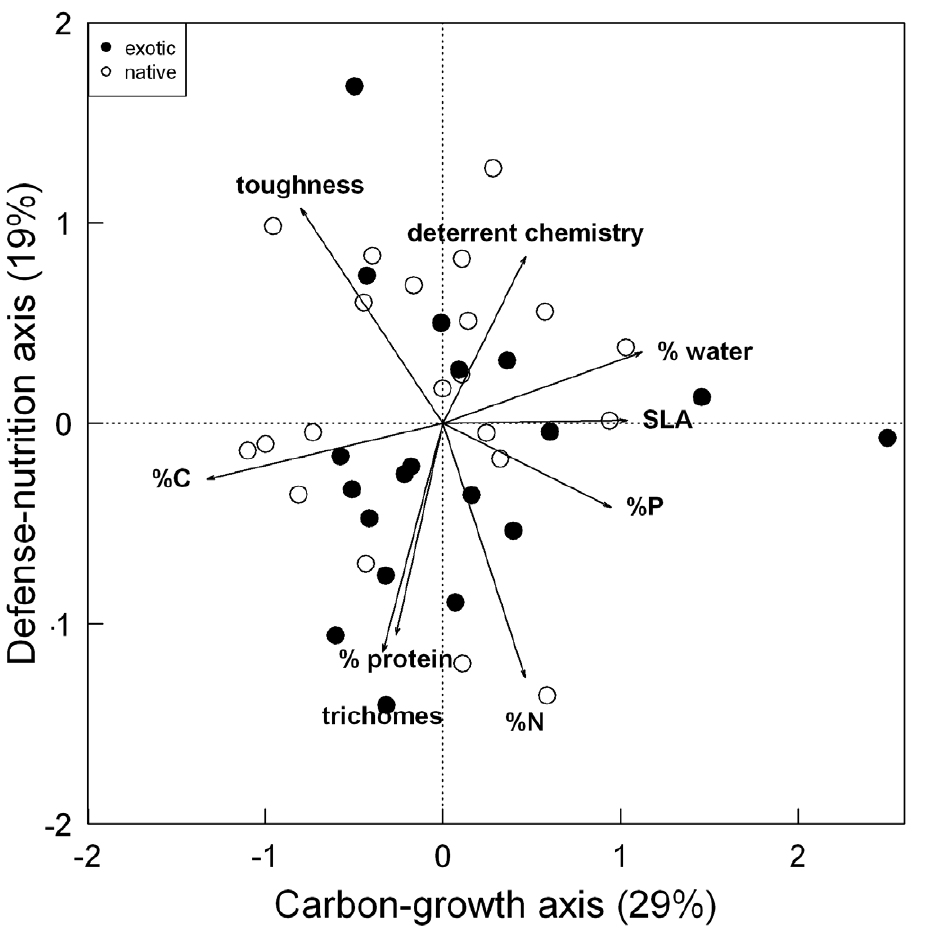
Figure 3. Native and exotic plant species occupy similar leaf trait space. Principal components biplot of native (open circles) and exotic (filled circles) species and their measured traits. PCA axis 1 (carbon-growth) explains 29% of trait variation across 19 exotic and 21 native species; PCA axis 2 (defense-nutrition) explains 19% of the remaining variation. All trait vectors are significantly associated with species PCA position according to randomization tests. Units for traits are given in Table 1.